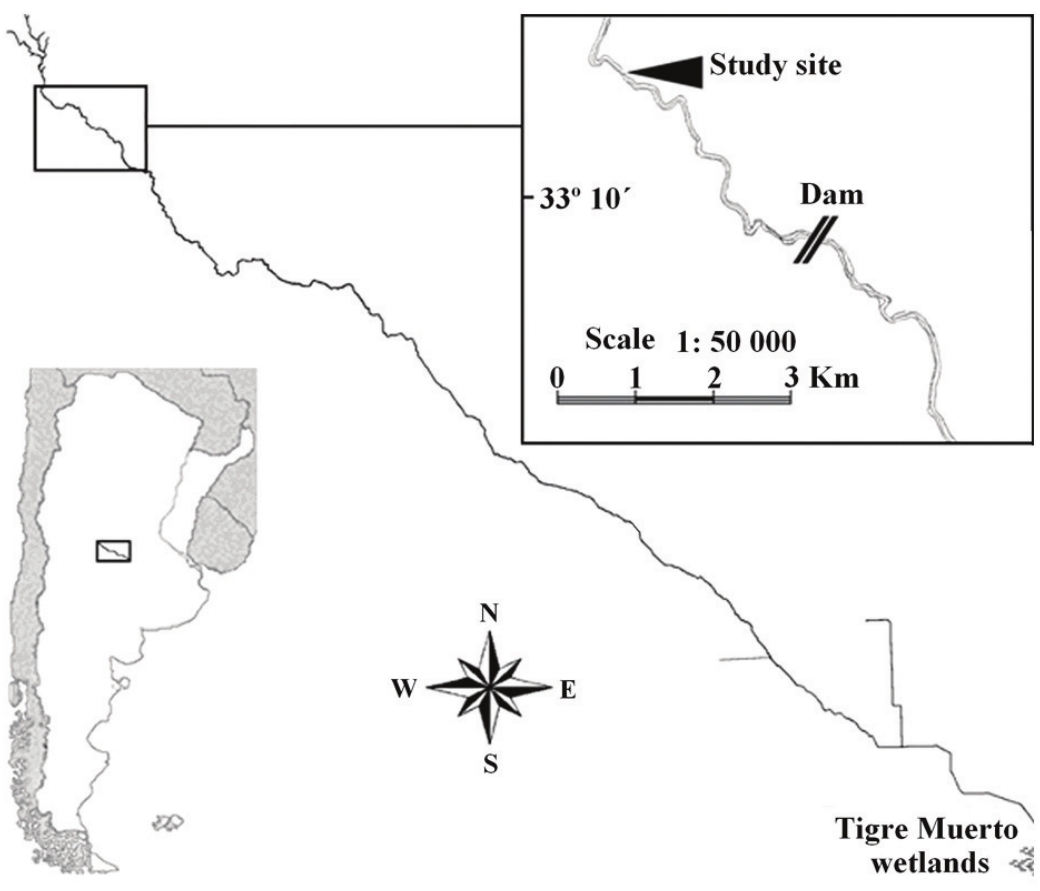
Figure 1. Study site location in Achiras stream, Córdoba province, Central